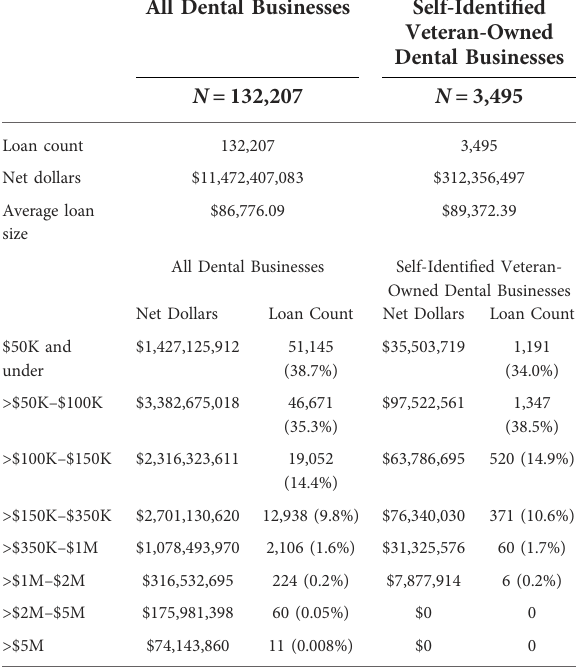
TABLE 1 Overview of Payroll Protection Program (PPP) approved lending for dental businesses and loan size distribution, based on veteran